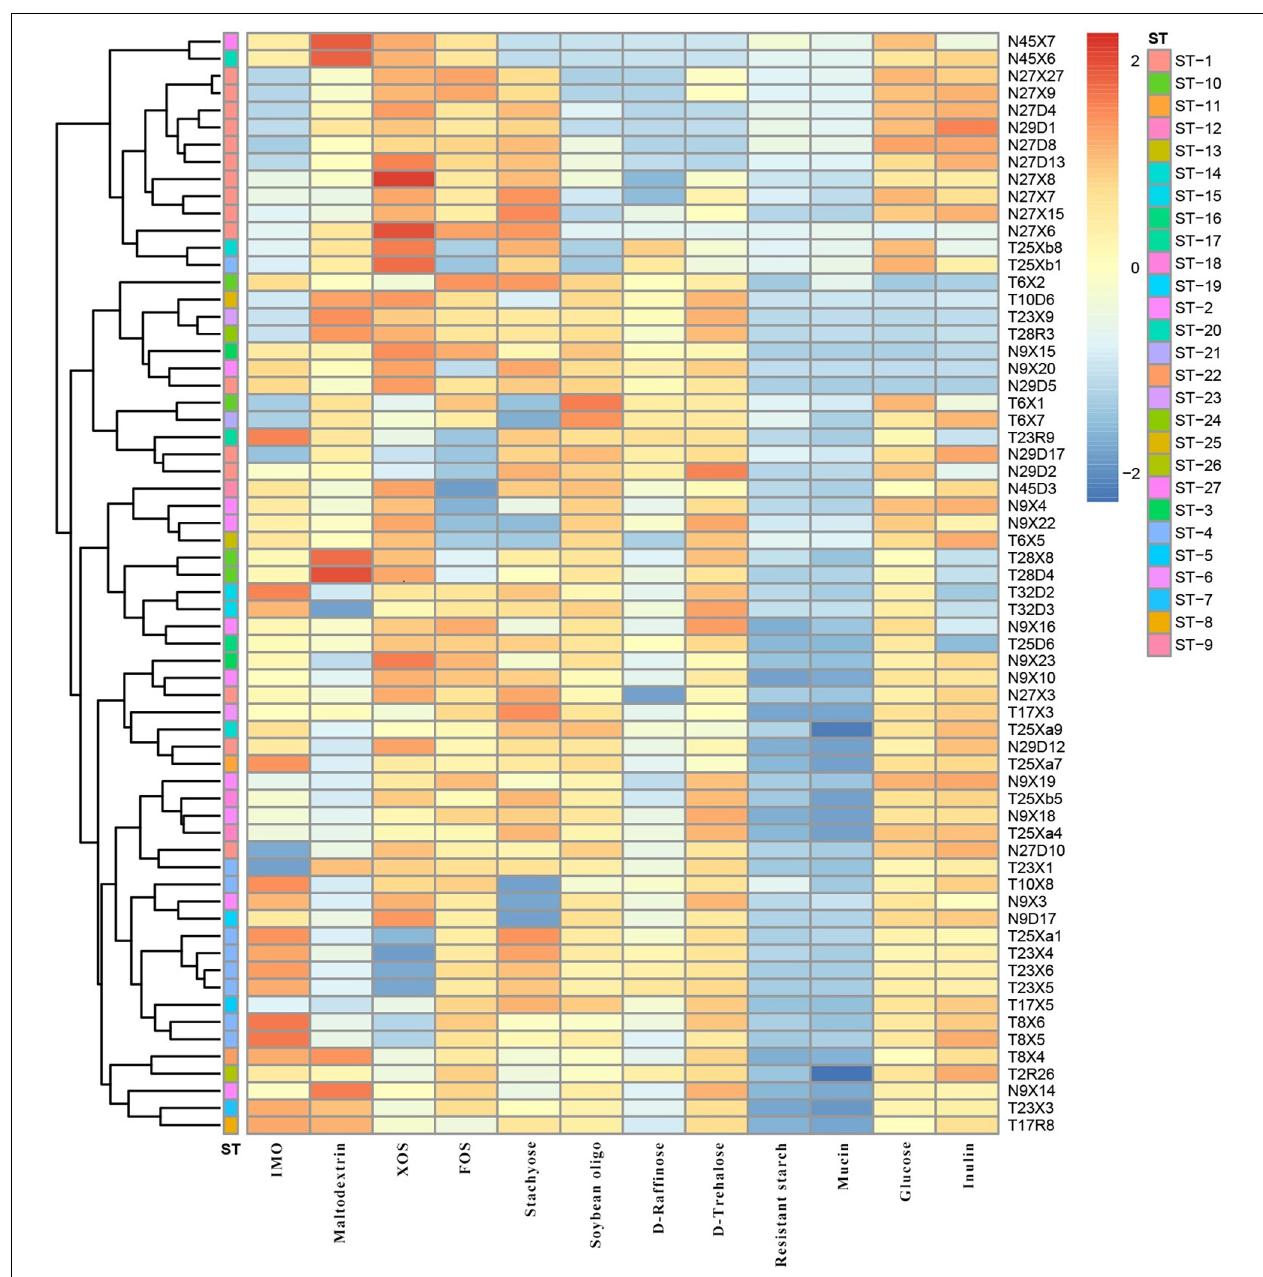
FIGURE 6 | The cluster analysis of polysaccharide utilization and STs of 64 representative L . paracasei